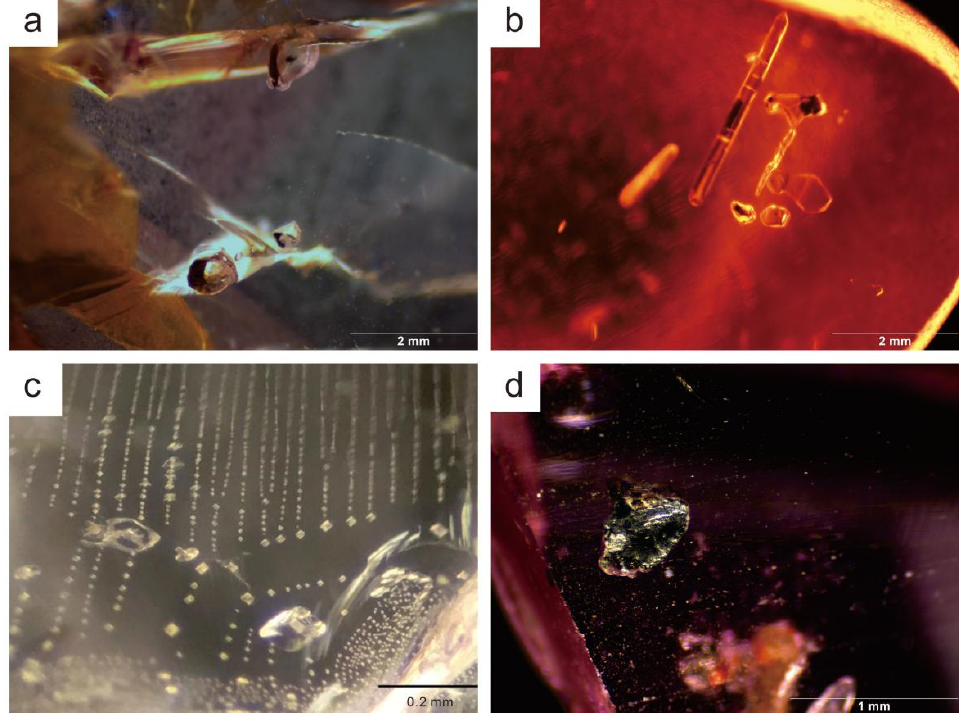
Figure 5. ( a ) Rounded crystal inclusions (apatite) in a Myanmarese spinel (M − 3). ( b ) Long columnar inclusion containing a black mineral (graphite or ilmenite) in a Myanmarese spinel (M − 4). ( c ) Octahedral negative crystals (calcite) arranged in very neat rows in a Myanmarese spinel (M − 10). ( d ) Brassy yellow metallic luster inclusion (pyrite) in a Myanmarese spinel (M − 5).